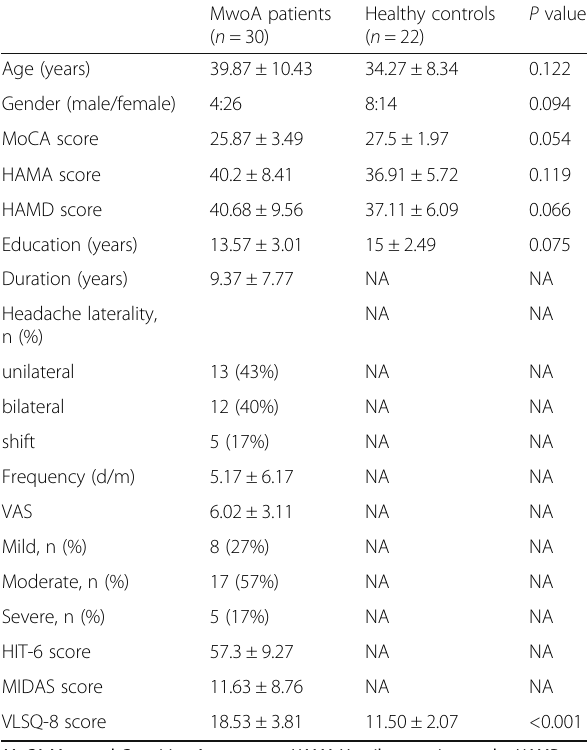
Table 1 Demographic and Clincal Characteristics of Participants MwoA patients ( n =